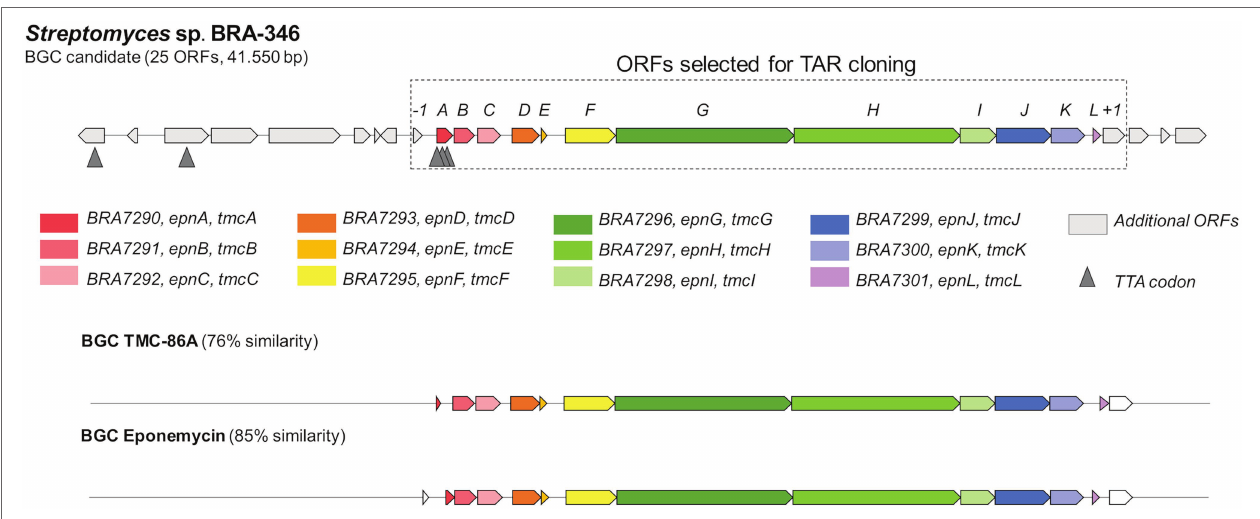
FIGURE 4 | Biosynthetic gene cluster of epoxyketone peptides in BRA-346. The epn/tmc BGC in BRA-346 was identified using antiSMASH. The related BGC of eponemycin ( epn , Streptomyces hygroscopicus ATCC53708; Schorn et al., 2014) and TMC-86A ( tmc , Streptomyces chromofuscus ATCC49982; Zabala et al., 2016) already reported are shown for